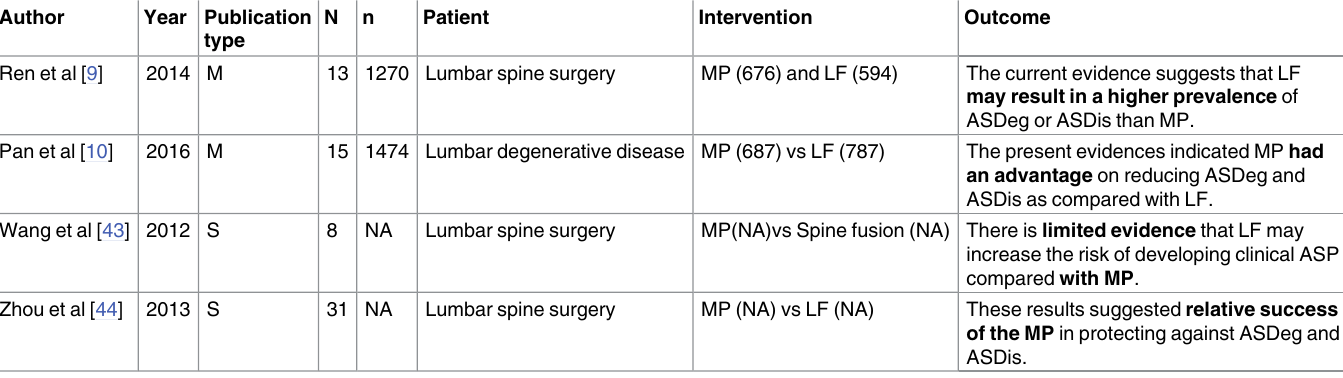
Table 6. Systematic review or meta-analysis of ASDis or ASDeg incidence rate between different interventions in lumbar spine